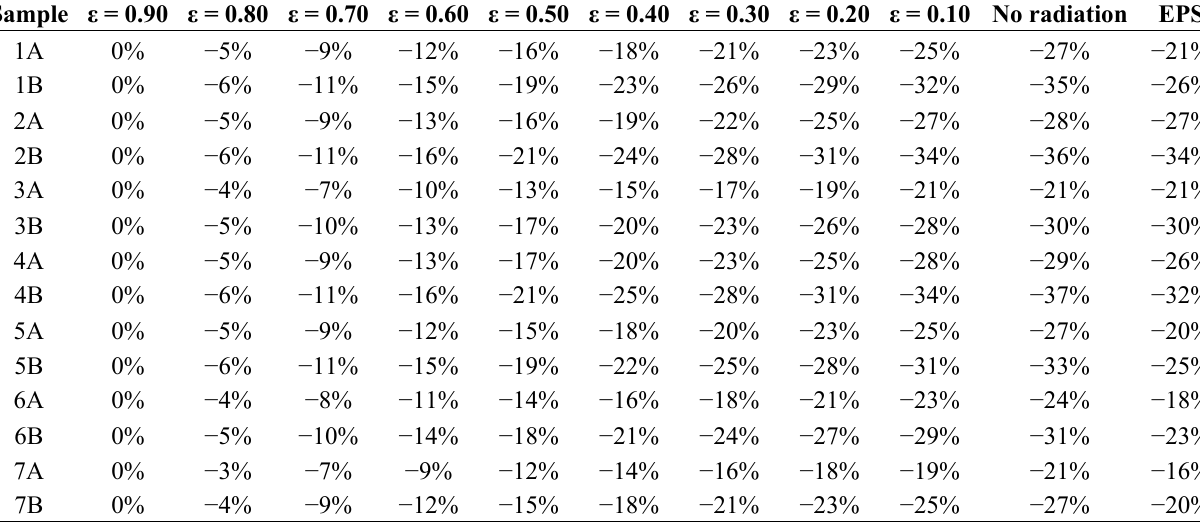
Table 9. Overall thermal transmittance of the wall built with the evaluated block: percentage of